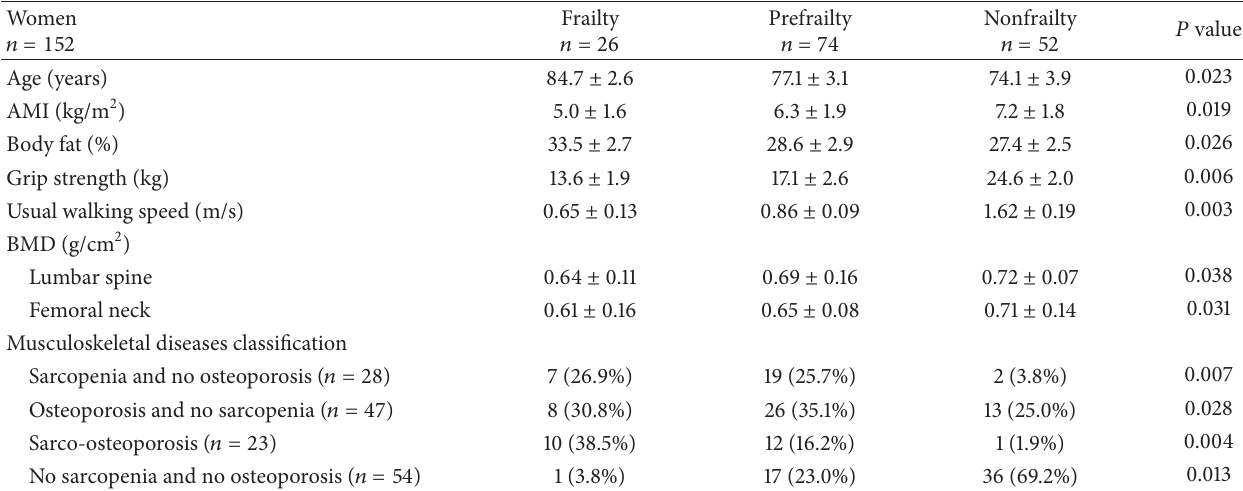
Table 5: Characteristics of women by presence of frailty/prefrailty.